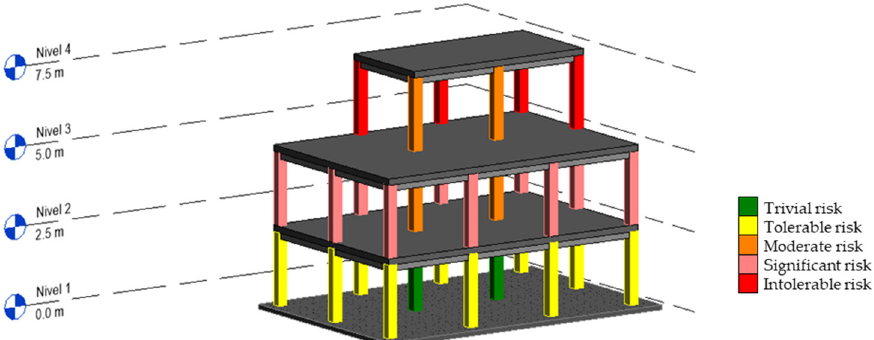
Figure 5. Classification of the level of risk associated with the construction of building columns in Autodesk Revit.